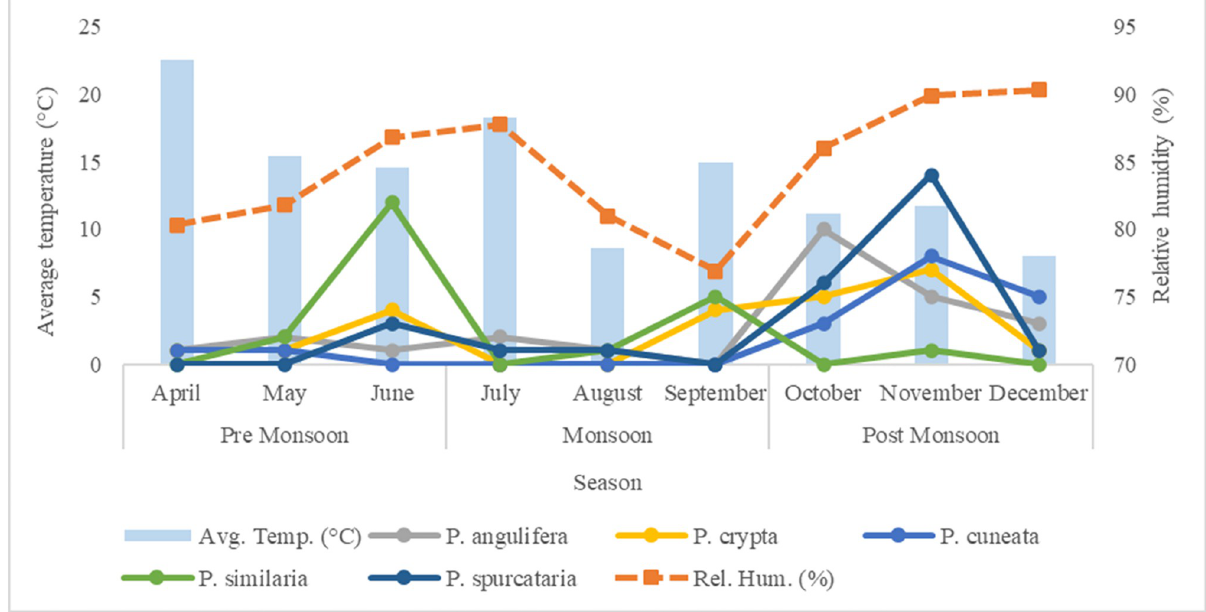
Fig 21. Abundance fluctuations of different Psyra species against average trap night temperature and relative humidity in respective months grouped into three broad seasons of Indian Himalaya during sampling period of 2010–2012 and 2016–2019.